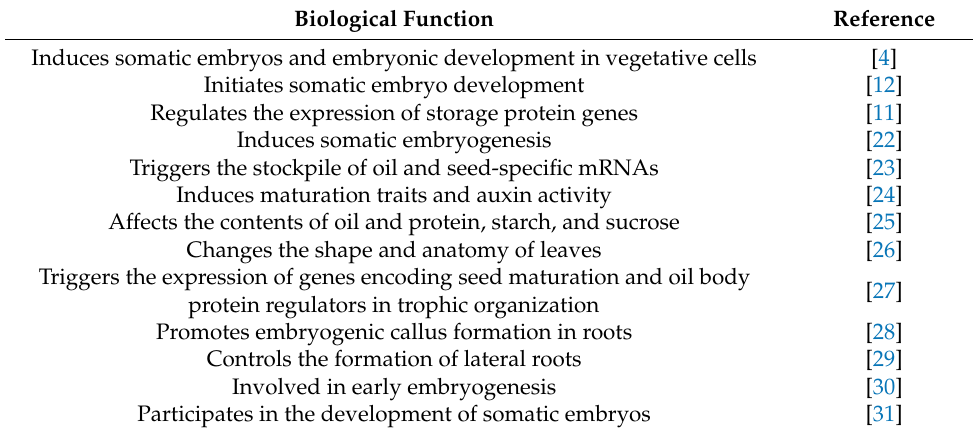
Table 1. Biological function of LEC2 transcription factor in A. thaliana